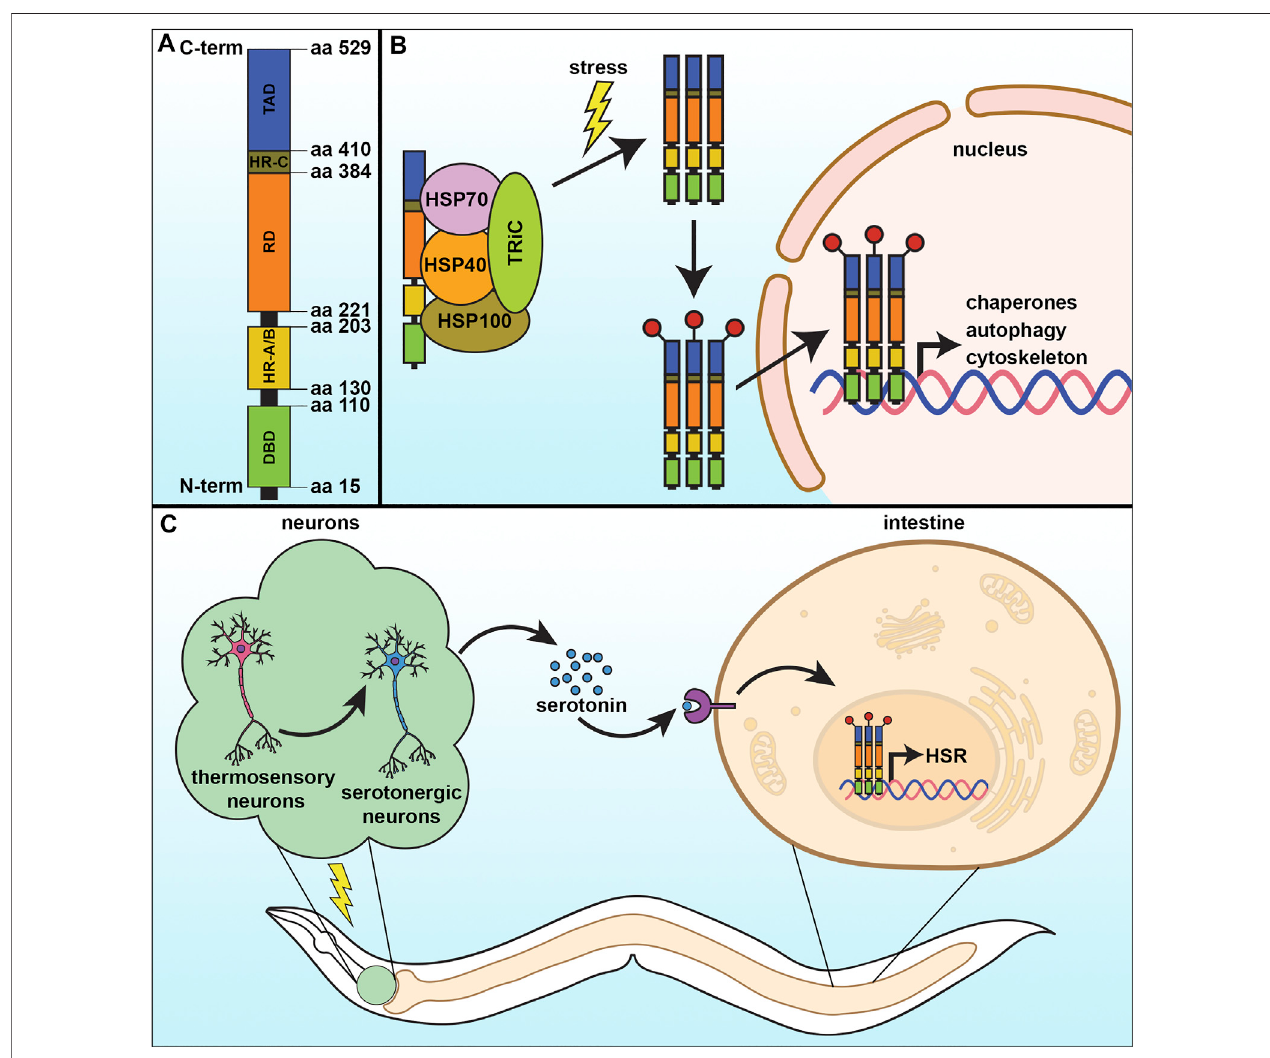
FIGURE 1 | The cytosolic heat-shock response. (A) The heat-shock response (HSR) is regulated by the transcription factor, HSF-1, which contains four major structural domains: the DNA-binding domain (DBD), regulatory domain (RD), trans-activating domain (TAD), and the oligomerization domain divided into HR-A and HR- B. (B) Underbasalconditions,HSF-1isbound byregulatoryproteins thatpreventits activation. Uponstress,these proteins arereleased fromHSF-1asthey aretitrated awaytoserveasmolecularchaperonestodamagedproteins,allowingHSF-1totrimerizeandserveasatranscriptionfactortoactivategenesimportanttomitigate damageandincreasesurvival. (C) TheHSRcanbecommunicatedinanon-autonomousmanner,wherebythermosensoryandserotonergic neuronscancommunicate to peripheral tissue, including the intestine, to activate a systemic HSR and promote organismal health and lifespan.